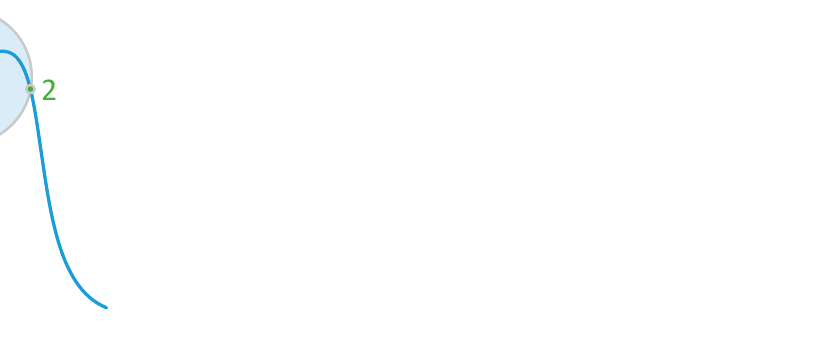
Figure 3. Schematic representation of the effect of terrain shading on model coverage.